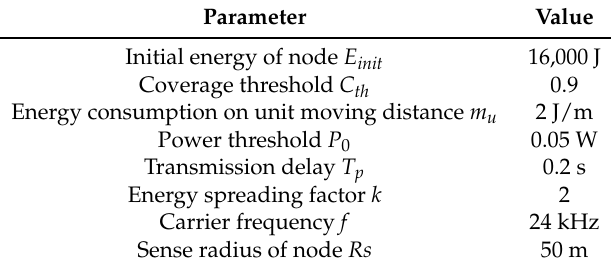
Table 2. Settings of Simulation Parameters.